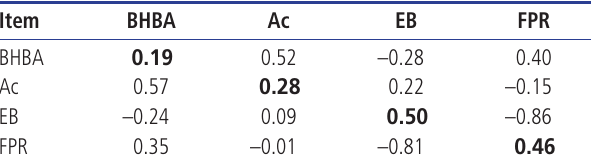
Table 2. Heritabilities (in bold in the diagonal) and genetic correlations (above the diagonal) and phenotypic correlations (below diagonal)